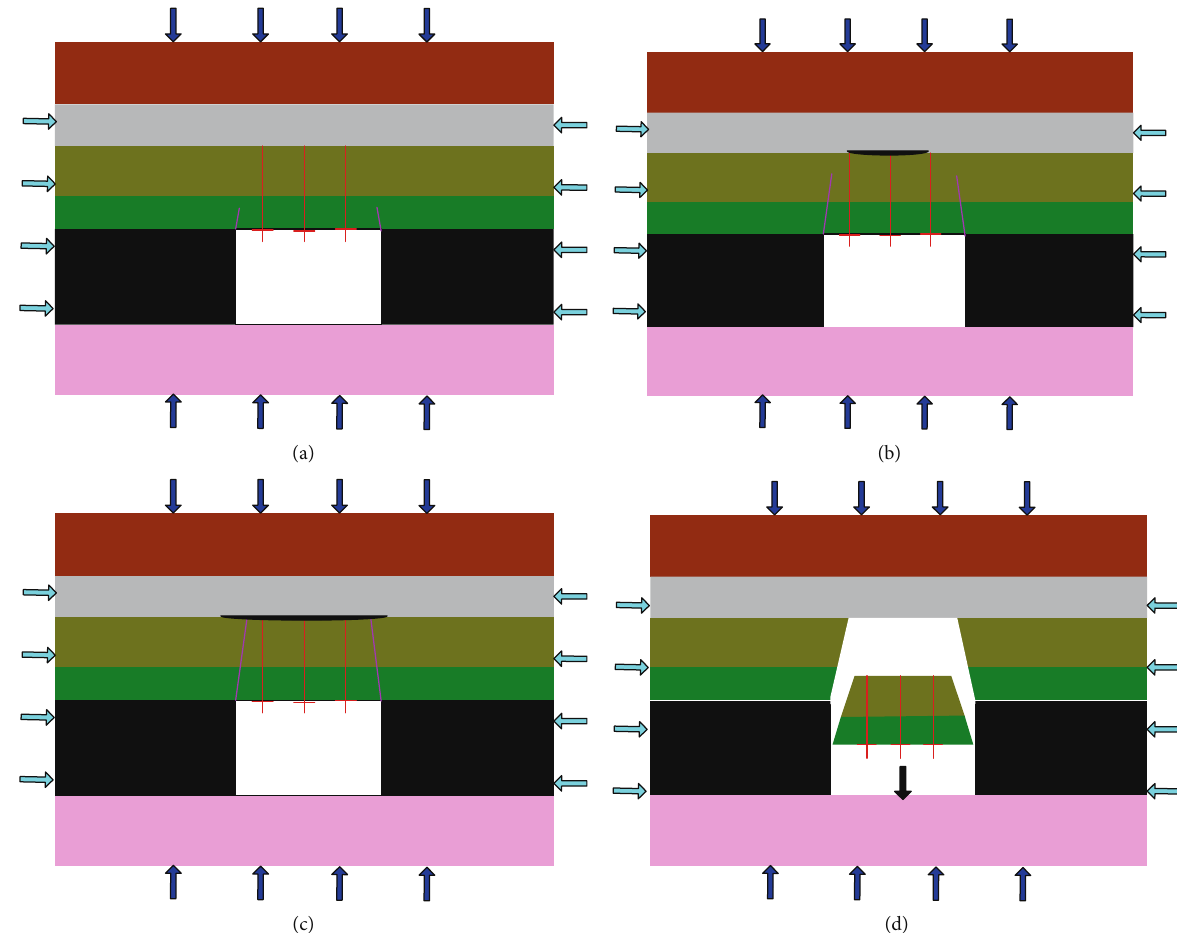
Figure 14: Evolution process of roof caving: (a) crack produce; (b) crack development; (c) fracture penetration; (d) roof